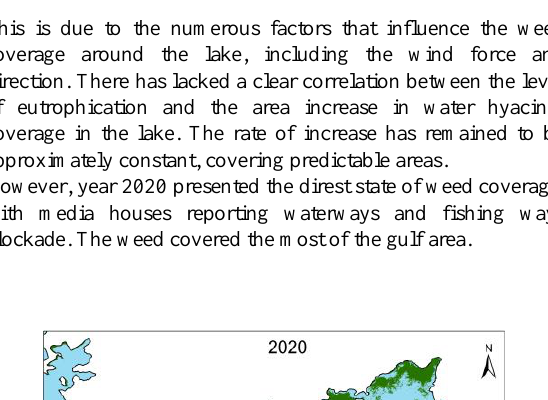
Figure 1 : The figure below shows the contribution of each year to the water hyacinth spread in Winum Gulf